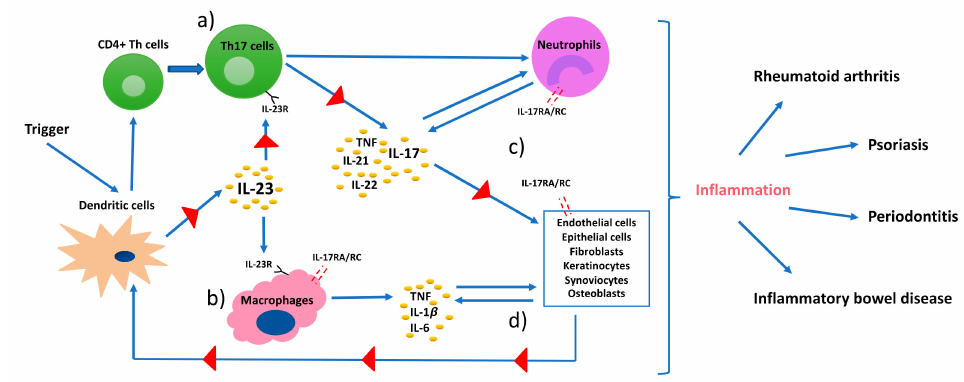
Figure 2. A pathophysiology model of immune-mediated inflammatory diseases. Dendritic